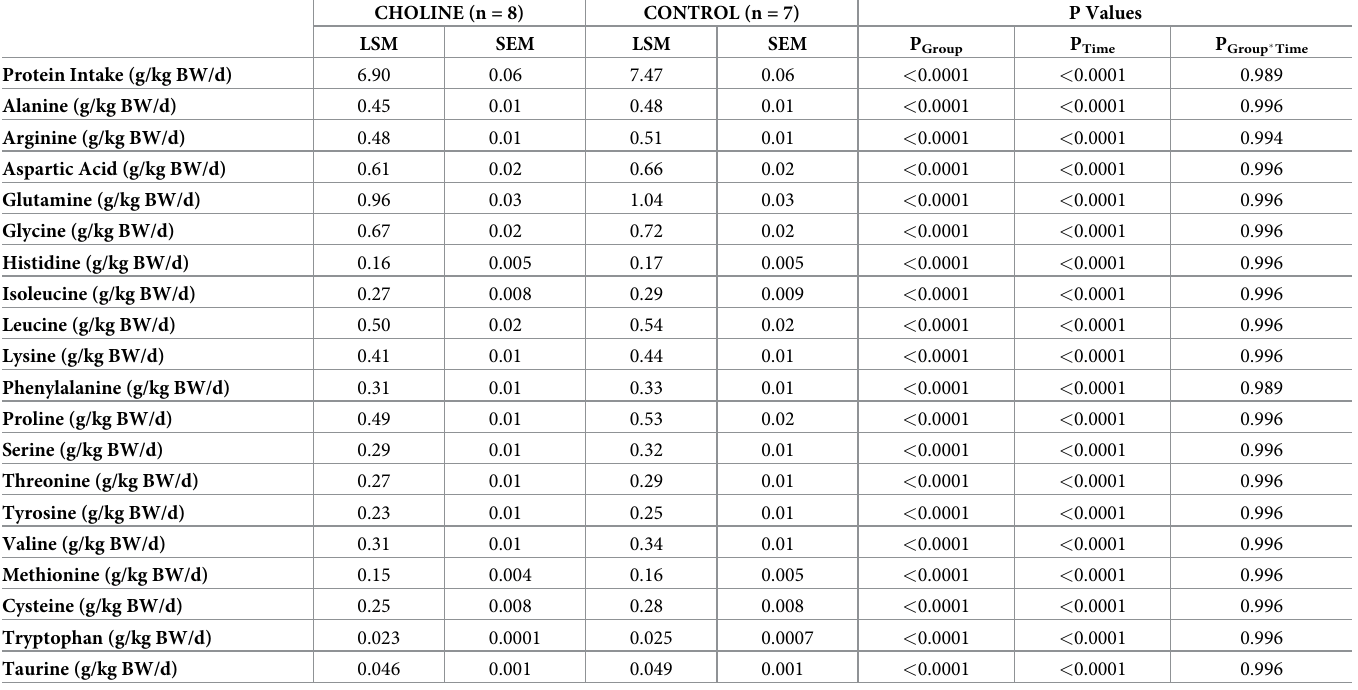
Table 2. Mean daily protein and amino acid intakes by UPLC over 12 weeks in kittens supplemented with additional choline at 300 mg/kg BW 0.75 (CHOLINE, n = 8) compared to a control group (CONTROL, n = 7) fed only the base